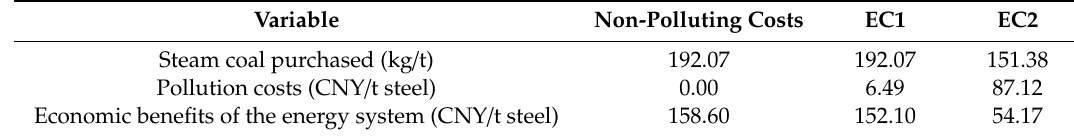
Table 7. Steam coal purchased, pollution costs, and economic benefits of the new